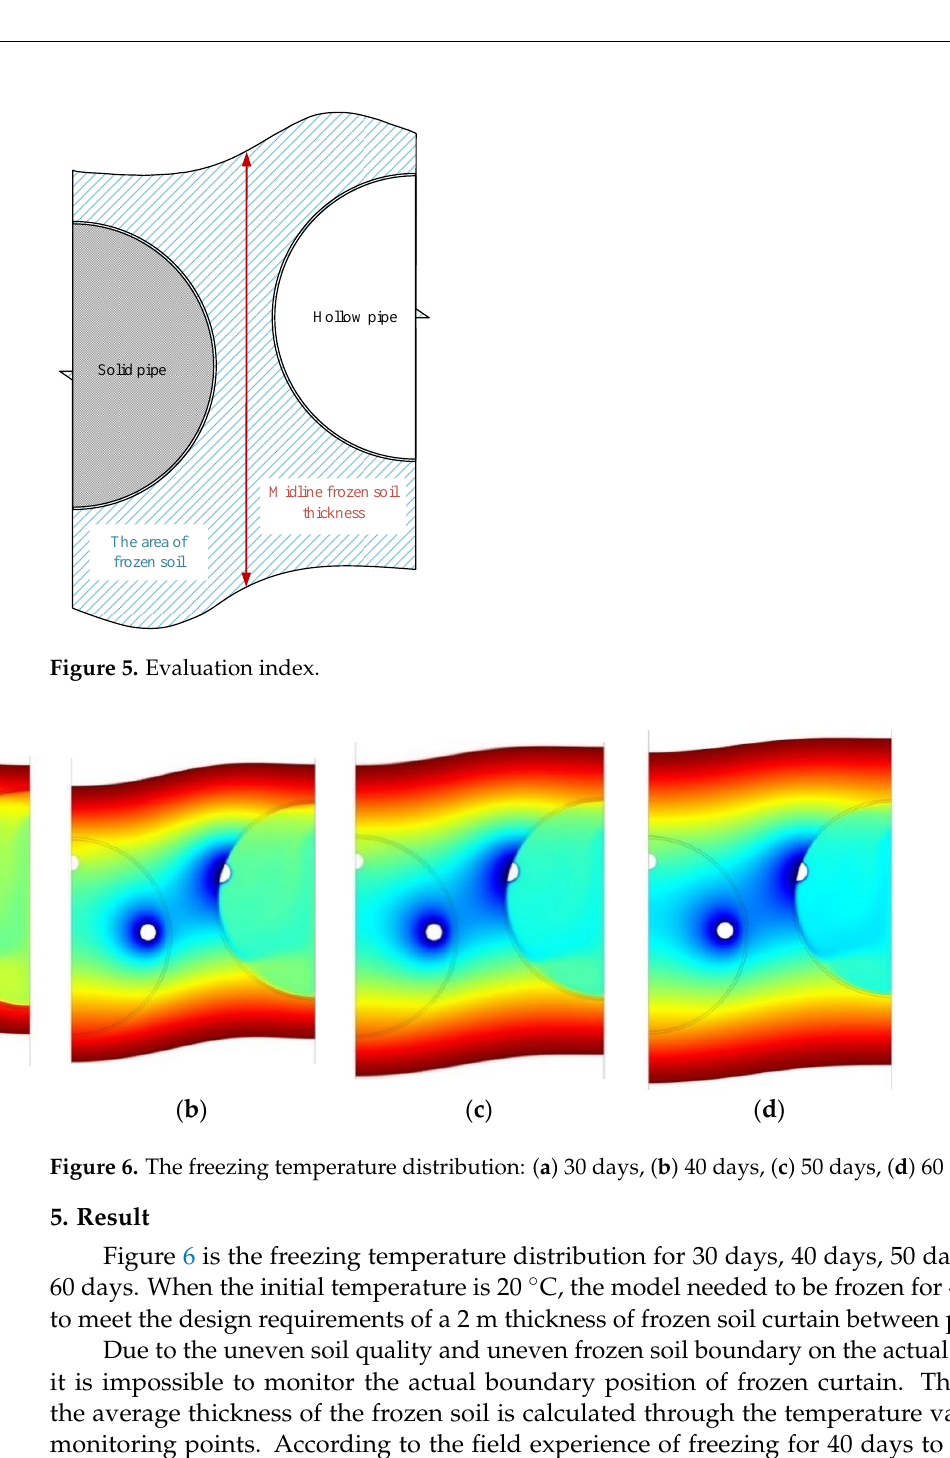
11 of 19 Table 6. Thermal conductivity of air (W/ (m∙K)) . Catalogue 1014 Table 7. Thermal physical parameters. Catalogue